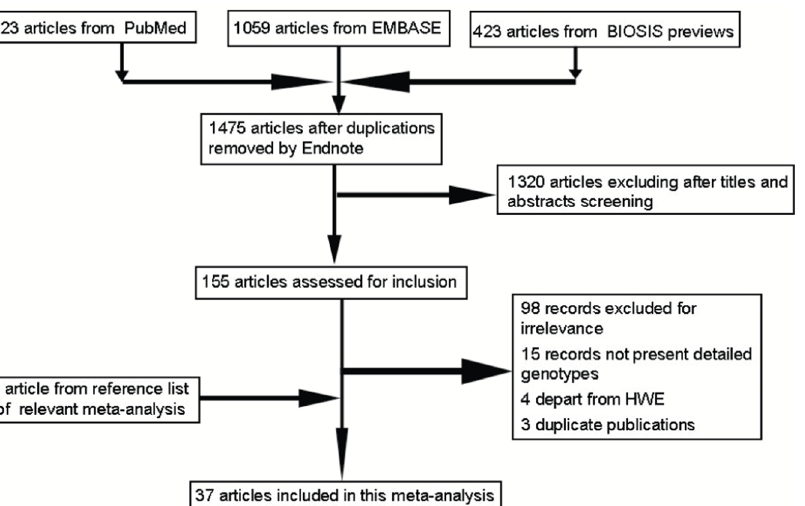
Figure 1. Flow Diagram for Inclusion of Studies in Meta-analysis. The initial search identified 2205 articles, of which, 37 were included in the final analysis.